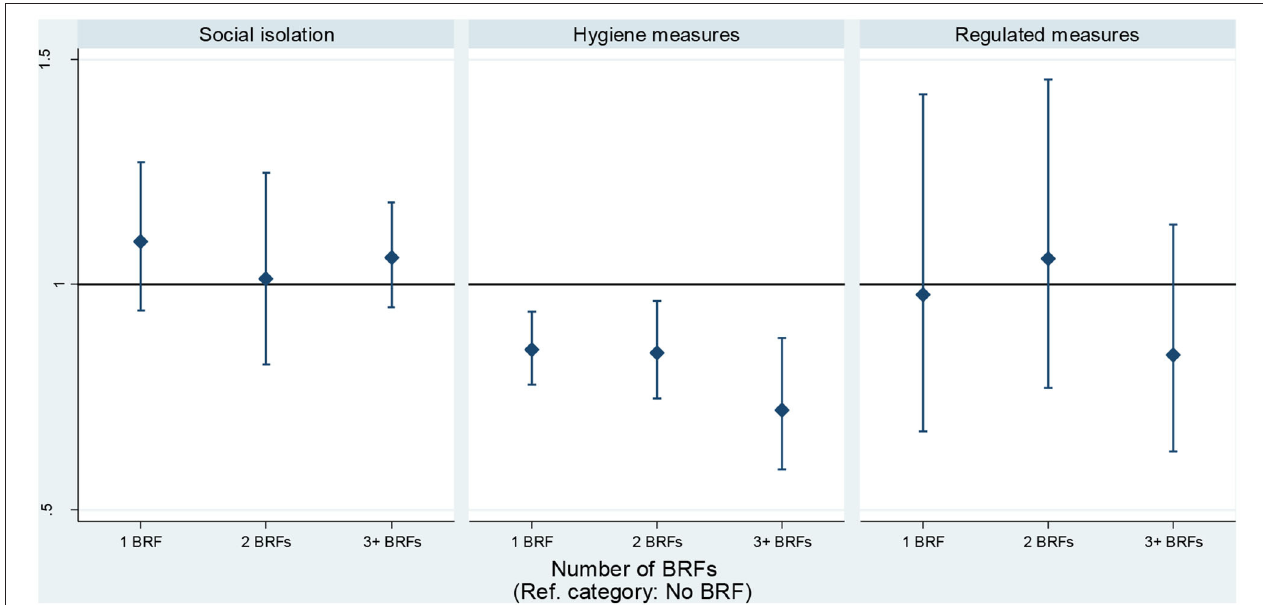
adherence to regulated measures. Table A5 in the Appendix presents the estimates for the disaggregated BRFs using as outcomes mask-wearing and keeping physical distance